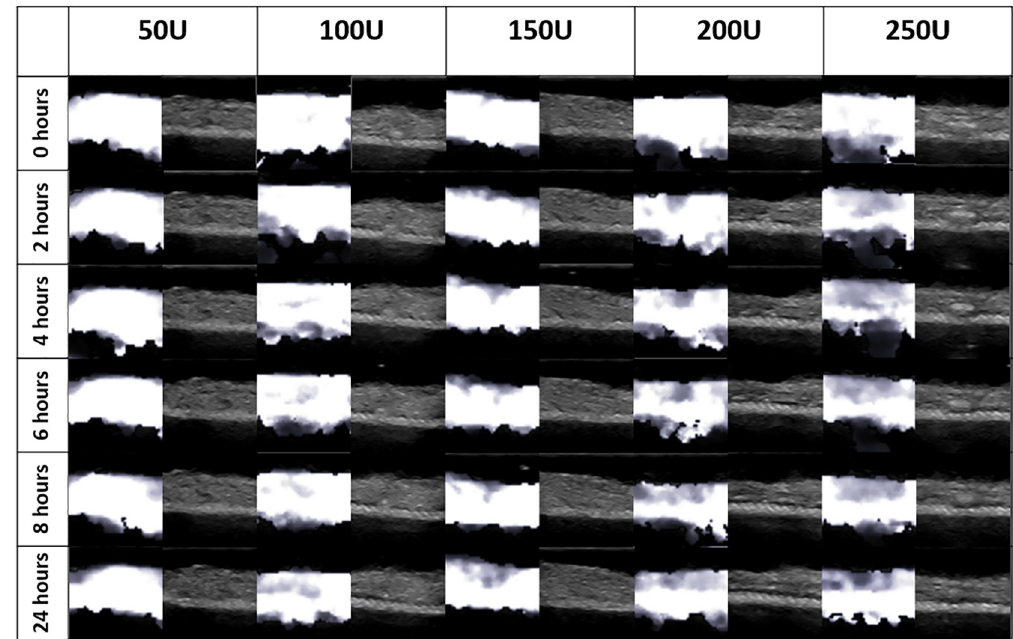
Fig 4. B-mode and shear wave elastography images collected at each injection site and time point for one sample. Greater shear wave speeds are represented by brighter grayscale values in the shear wave elastography